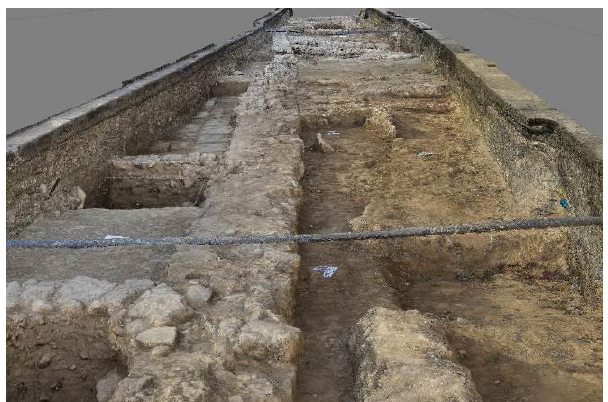
Figure 6: 3D Model of St. Francis Street Excavation Area,